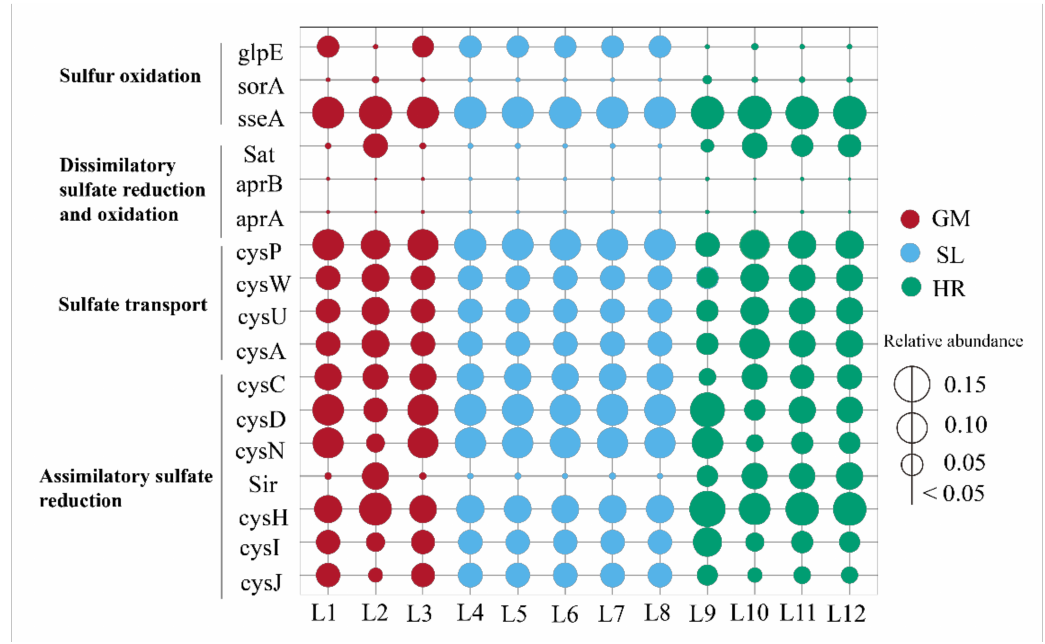
Figure 6. Relative abundances of sulfur metabolizing genes in the subsidence lake and its connected river; SL: subsidence lakes; GM: coal gangue mountain waters; HR: Huihe